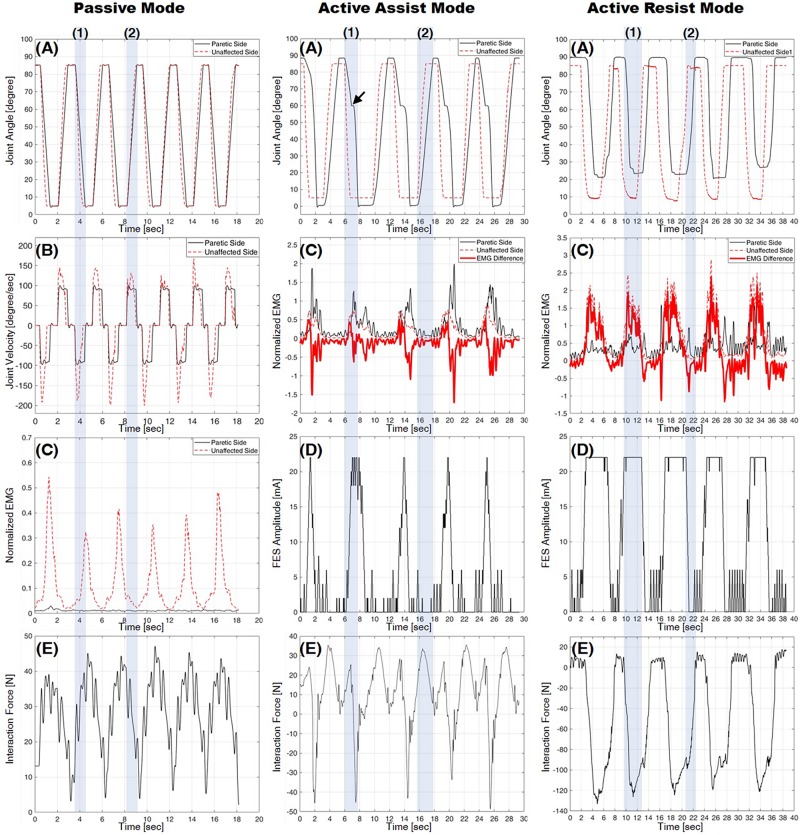
Experimental results from three operation modes: the passive mode in the first column, the active assist mode in the second column, and the active resist mode in the third column. (A) Knee joint angle, (B) knee joint velocity, (C) normalized EMG, (D) FES amplitude, and (E) interaction force (positive for compression, negative for tension). Shading boxes (1) and (2) indicate the knee extension (from 90° to 0°) and flexion (from 0° to 90°), respectively.